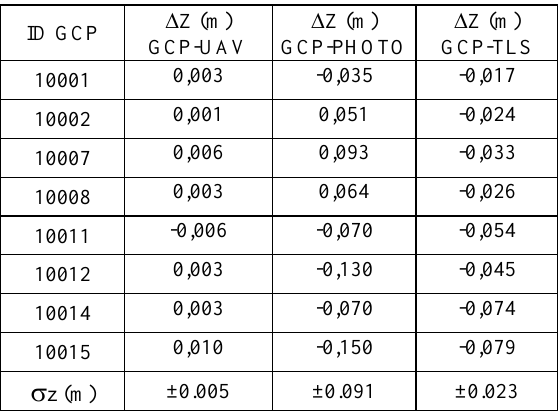
Table 3. Synthesis of the residual and standard deviaton